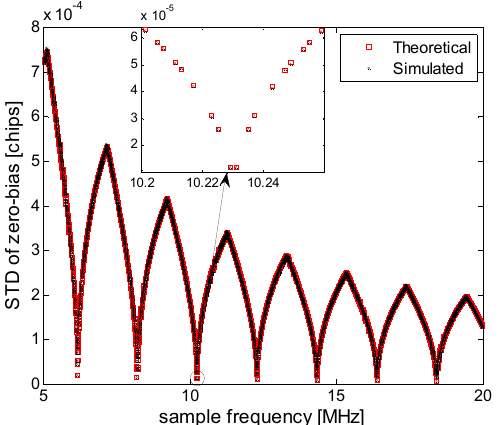
Figure 7. Standard deviation of the zero-bias of the BOCs (1, 1) signal corresponding to different sampling frequencies ( F c = 1.023 MHz, F sc = 2.046 MHz, 2 d c = 1 ms).